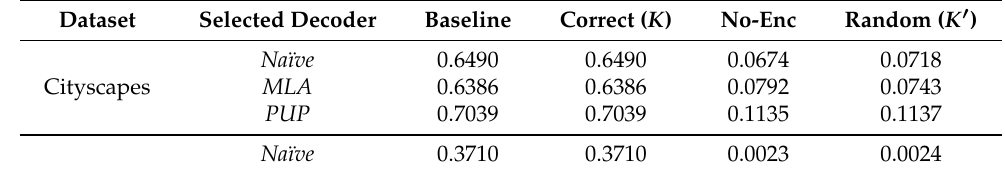
Table 1. Accuracy of proposed models ( mIoU ).